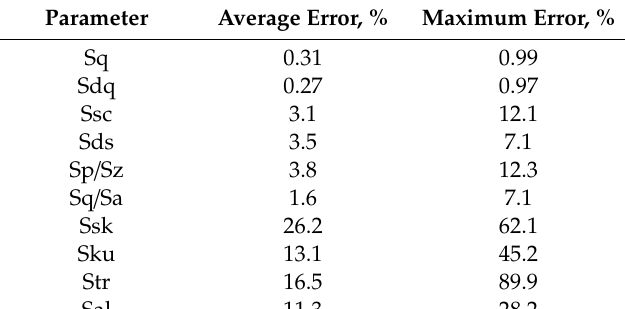
Table 2. Relative errors of parameters predictions.